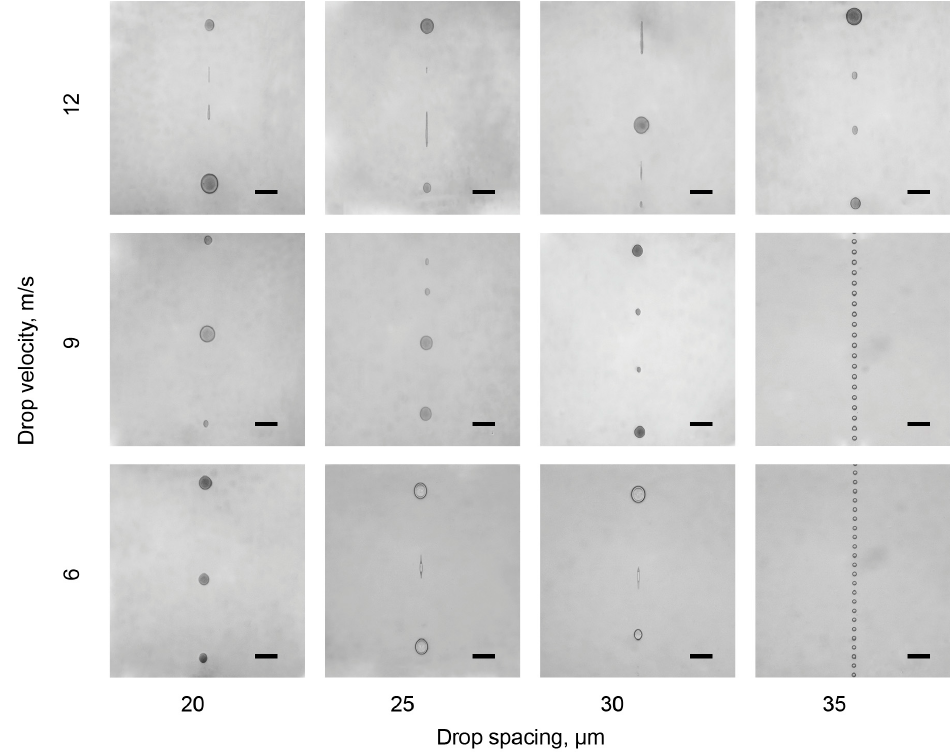
Figure A4. Array of optical images of a 1 pxl line printed on PDMS when cured for 7 min at 80 °C depending on drop spacing and velocity. The scale bar is 100 µm.